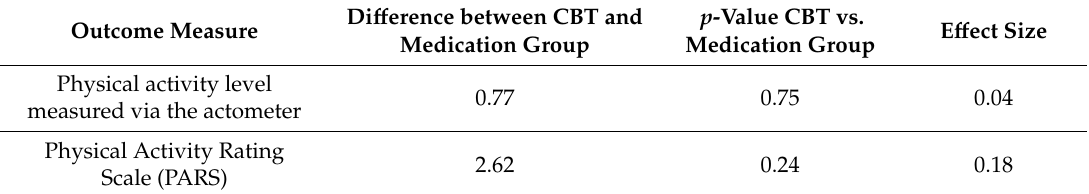
Table 6. Di ff erences between CBT and medication groups in changes in physical activity level from baseline to the end of